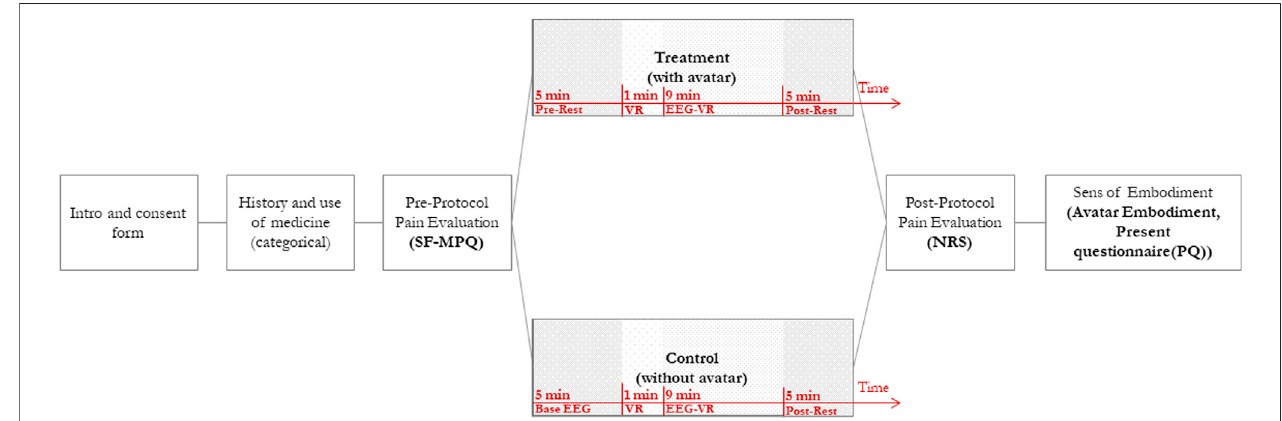
FIGURE 1 | Study Design. This fi gure shows the process of the study. Patients will be introduced to the study, and their pain will be evaluated. Each patient will be assignedtoeither thecontrolortreatment groupinpseudo-randomorder. TheVRsessionisdividedintofour intervals:(a) Pre-Rest — capturingpre-interventionresting- stateEEGdatawithEyesClosed(EC),(b)VR — ImmersionandexplorationinVR,(c)EEG-VR — staticVRexperience(nophysicalmovement)EEGsamplingand,(d)Post- Rest — capturing post-intervention resting-state EEG data with Eyes Closed (EC). After the VR session, pain levels and a Sense of Embodiment will be assessed using a Numerical Rating Scale (NRS) and an avatar embodiment